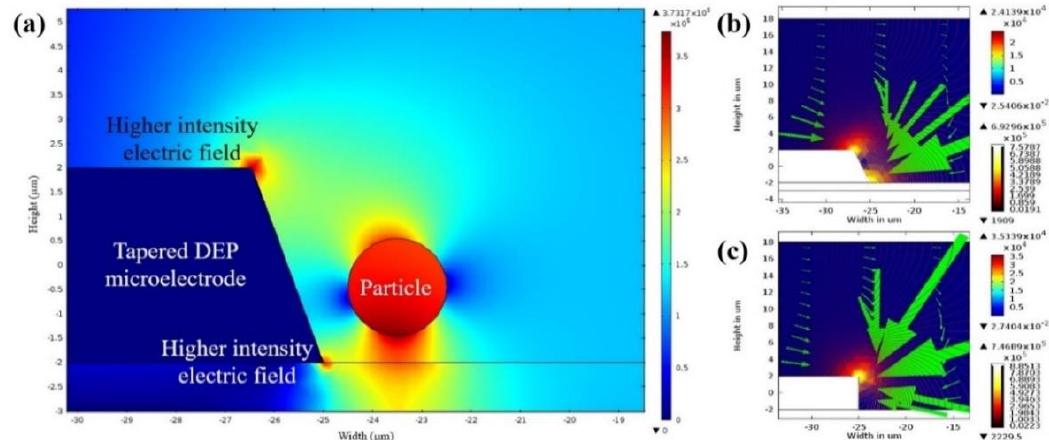
Figure 4. The FEM analysis of ( a ) the tapered microelectrodes at 70 ° electric field gradients, ( b ) the P DEP at 70 ° and ( c ) the P DEP at a 90 ° side wall angle.